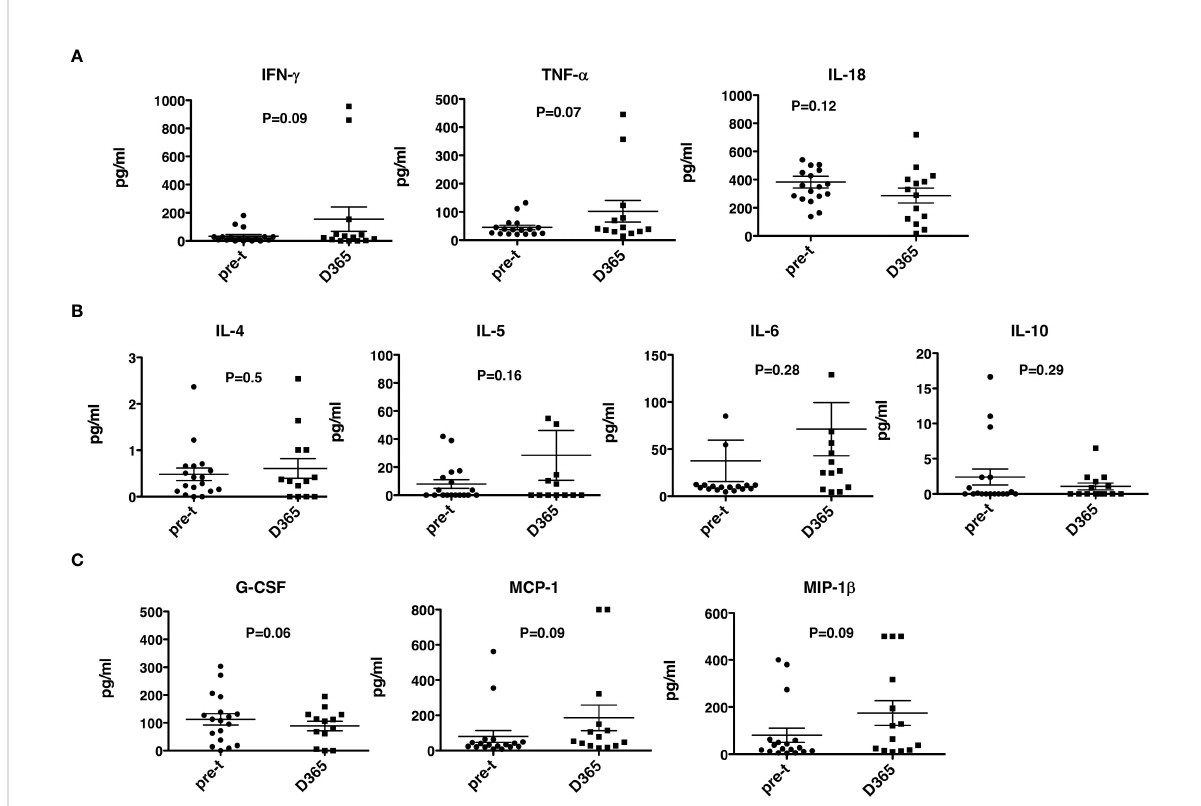
FIGURE 5 Th1 and Th2 cytokines and growth factors. Th1, Th2 cytokines and growth factor levels were determined in plasma before and 365 days after HSCT. (A) Th1 cytokines IFN- g , TNF- a and IL-18 levels. (B) Th2 cytokines IL-4, IL-5, IL-6, and IL-10 levels. (C) G-CSF, MCP-1 and MIP-1 b . HSCT, haploidentical stem cell transplant; ELISA, enzyme-linked immunosorbent assay; INF, interferon; TNF, tumor necrosis factor; GCSG, granulocyte colony stimulating factor. pre-t, pre-transplant; D,